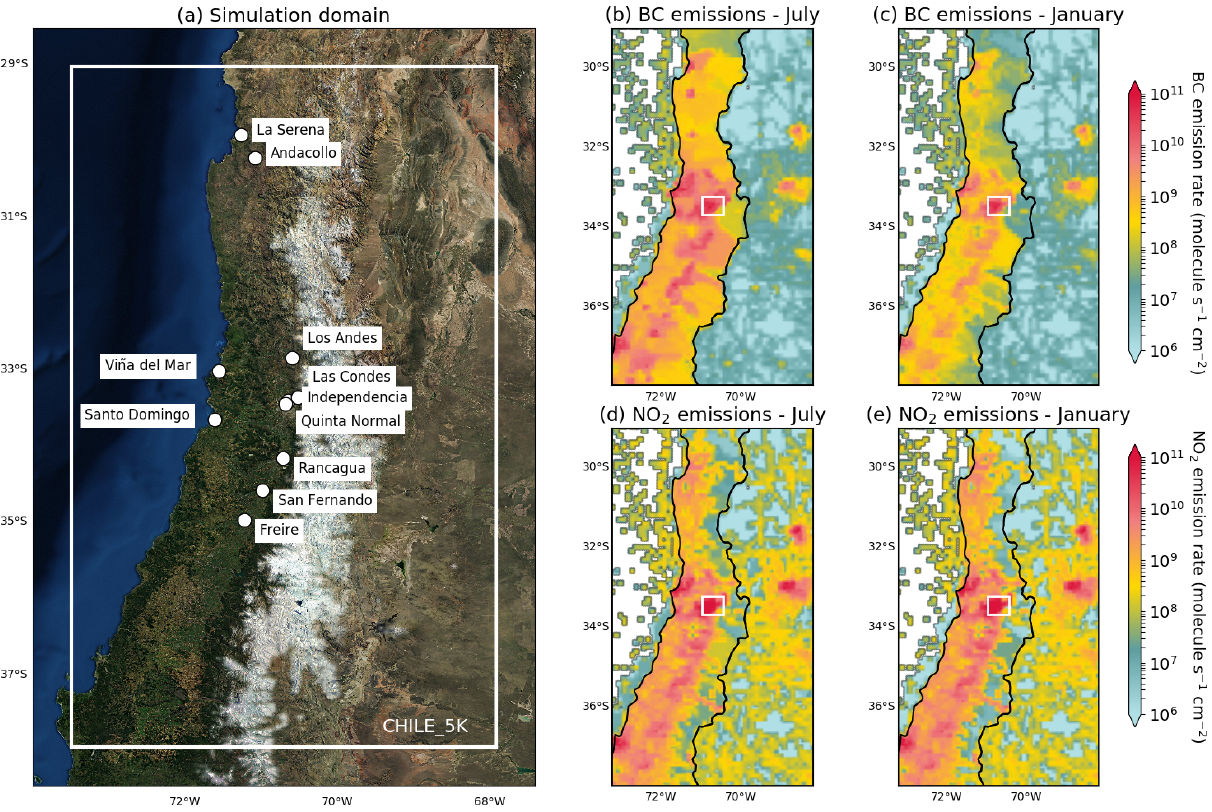
Figure 1. (a) Simulation domain at 5km spatial resolution centered over Santiago. Locations of interest are designated with white dots. (b) Daily average surface emission rate of black carbon (BC) for July 2015 and (c) January 2015 and for nitrogen dioxide (NO 2 ) for (d) July 2015 and (e) January 2015. Map background layer source: Imagery World 2D, ©2009